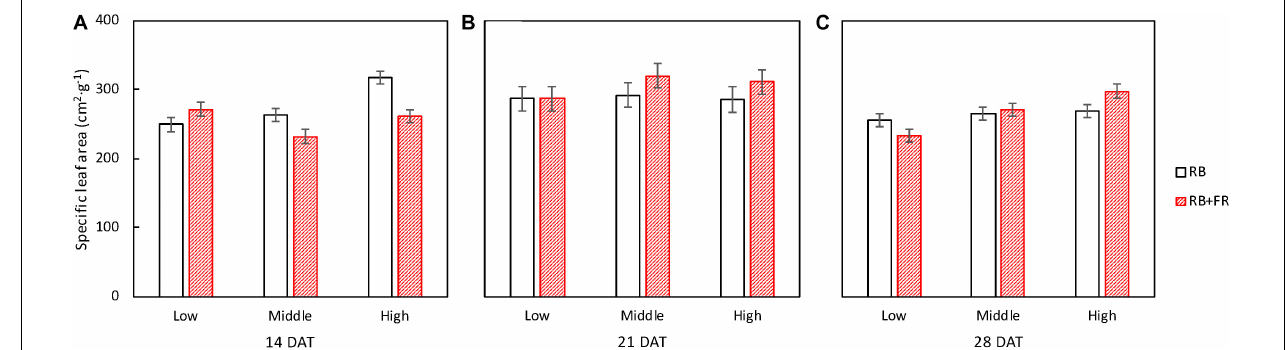
FIGURE 7 | Specific leaf area (SLA) of lettuce plants grown at three planting densities (23, 37, and 51 plants m − 2 ), with (52 µ mol m − 2 s − 1 ) and without far-red radiation (FR) at 14 (A) , 21 (B) , and 28 (C) days after transplanting (DAT). Error bars indicate standard errors of means. For 14 DAT, a significant interaction between FR and planting density was observed ( P = 0.027; n = 2). For 21 DAT, no significant interaction ( P = 0.70) between effect of planting density ( P = 0.59) and effect of FR ( P = 0.26) was found. For 28 DAT, there was a significant interaction ( P = 0.055; n = 3). Data are means of two ( n = 2) or three blocks ( n = 3) each with four–six replicate plants.